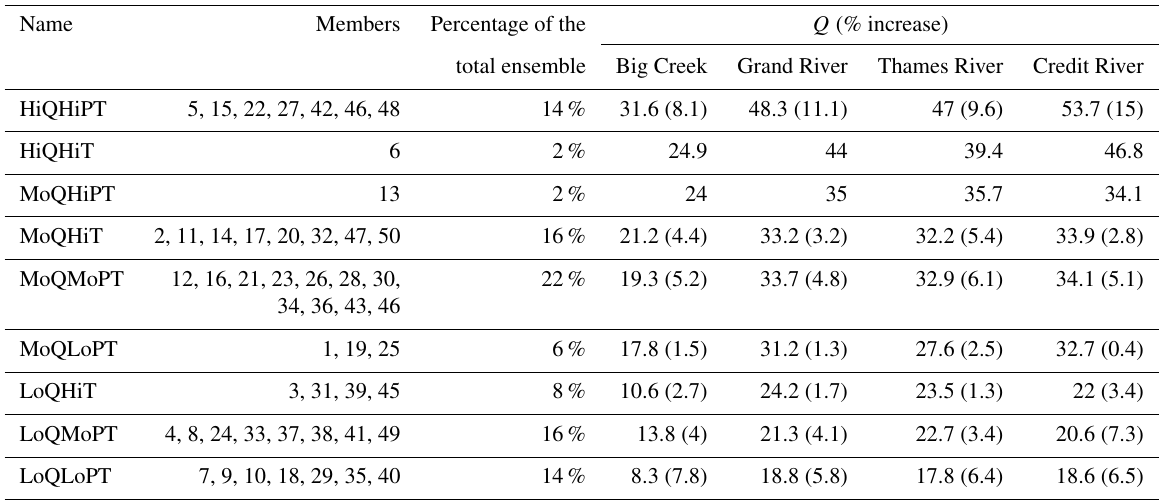
Figure 6. (a–b) Results of the agglomerative hierarchical clustering (AHC) for (a) the normalized change of streamflow ( Q ) and (b) normal- ized change of average temperature ( T ) and precipitation (PP). Colored numbers represent Q classes in panels (a) and (b) . (c) Four-watershed average change of streamflow ( Q ) (colors) with respect to the average change of PP and T . Large hollow circles represent the four weather classes. Table 4. Class members, percentage of the ensemble in the class and average January–February percentage increase of streamflow between the historical and the 2040s periods. The term in parenthesis indicates the standard deviation when the class has more than two